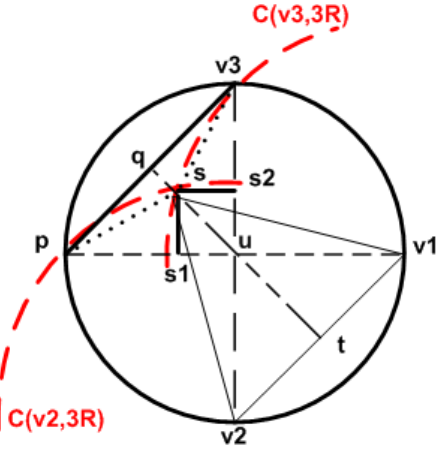
Fig. 2. A figure illustrating the computation of P 1